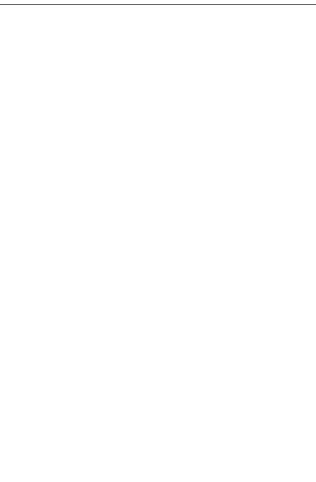
FIGURE 7 | The funnel plot of